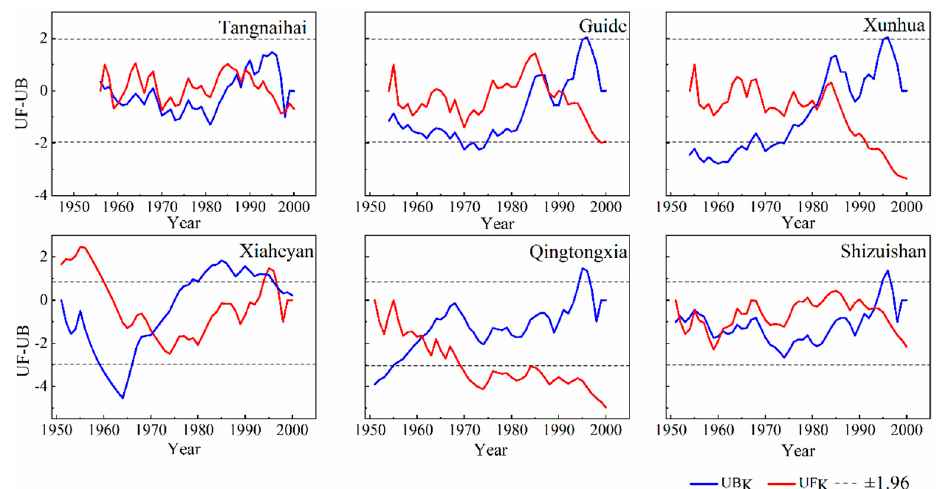
Figure 5. MK trend analysis for the baseflow at the six hydrological gauging stations.